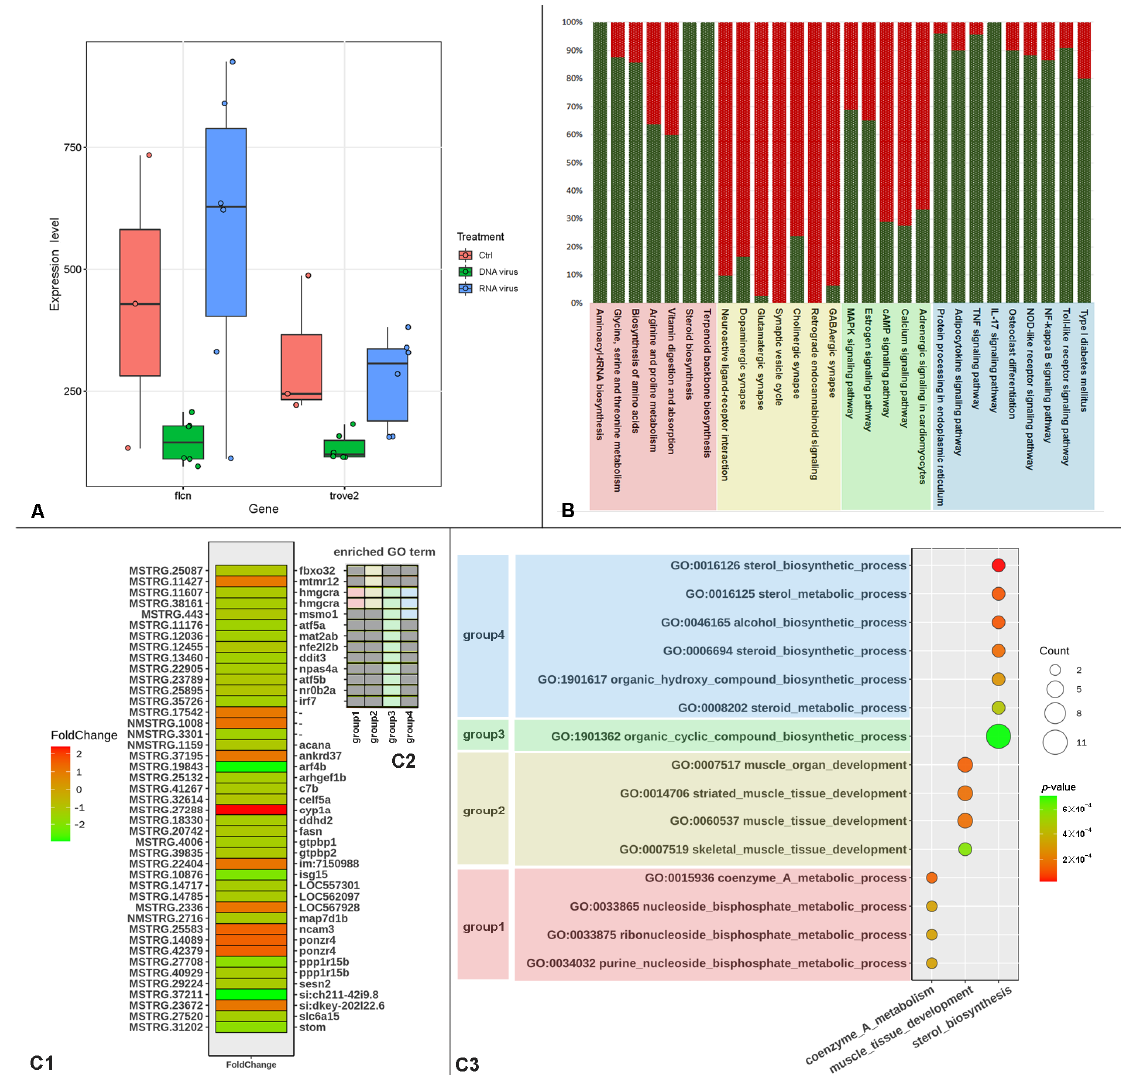
Figure 4. Summary of DEG analysis by dimensions. ( A ) Expression levels of two DEGs between DNA virus and RNA virus. ( B ) Percentage stacked bar chart of the enriched pathways based on DEGs between infections by two RNA viruses. Red block: metabolic-related pathways. Yellow block: nerve signal transmission pathways. Green block: signal transduction pathways. Blue block: immune-related pathways. ( C ) DEGs and enriched GO terms between the infections by two DNA viruses. ( C1 ) The heat map of the log2 (fold change) of 43 DEGs with nr alignments. ( C2 ) Grid graph to show DEGs corresponding to the four groups of enriched GO terms. ( C3 ) The first 15 enriched GO terms of biological process (BP) with the lowest p -value. The x-axis is for the function categories of the GO terms. The y-axis coordinate was the four groups of GO